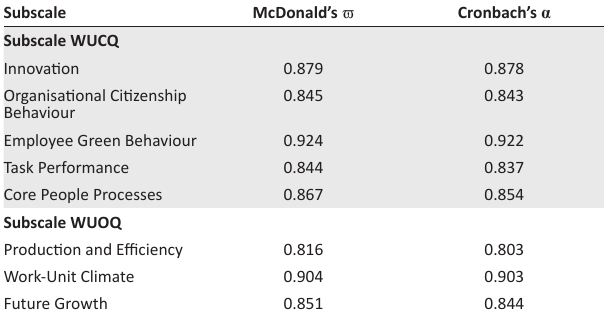
TABLE 3 : McDonald’s ϖ and Cronbach’s α for the Work-Unit Performance Questionnaire subscales for which the unidimensionality assumption had been corroborated.